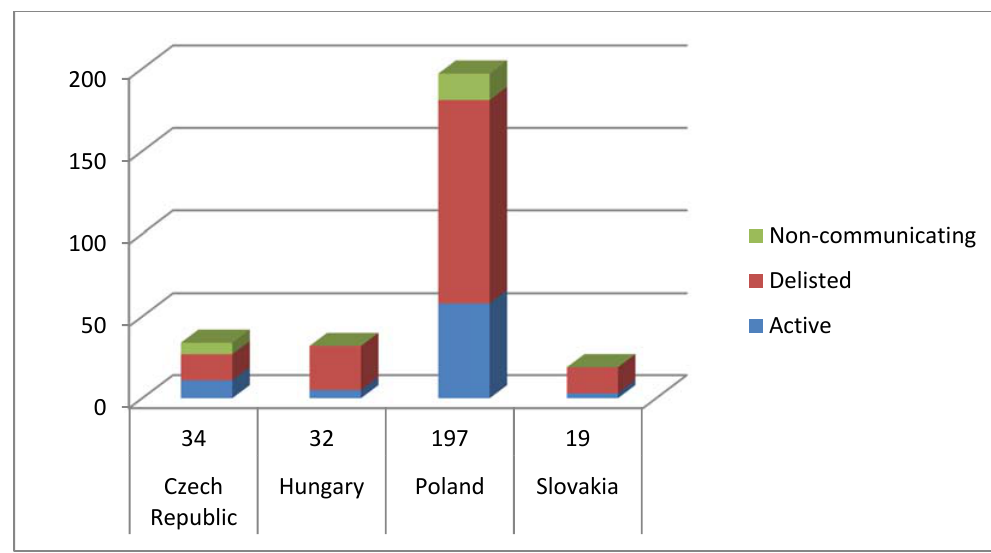
Figure 1. Participants in the United Nations Global Compact (UNGC) from V4 countries by the end of 2019.